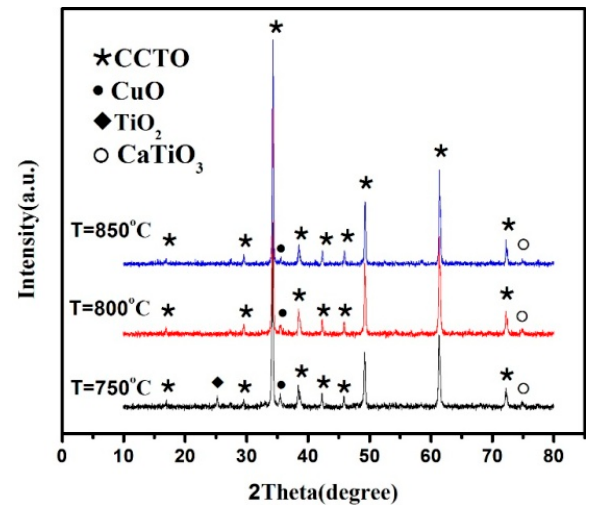
Figure 2. XRD patterns of submicron CCTO at different calcination temperatures.